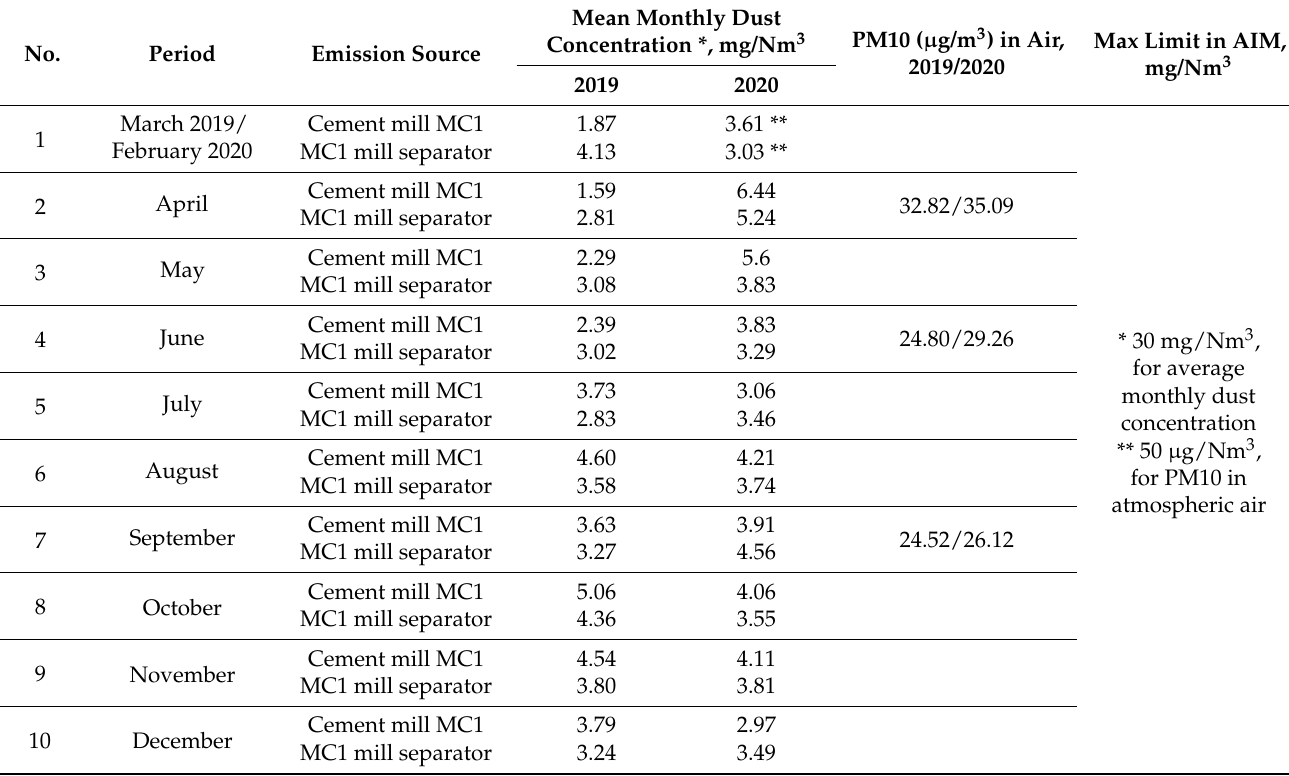
Table 1. The results of the measurements regarding the dust emissions at the two stacks of the cement mill MC1 of the cement factory for 2019.